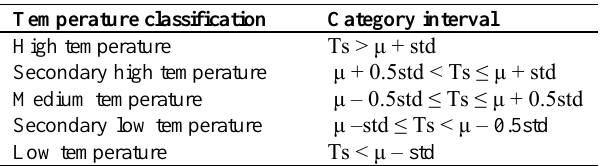
Table 1 LST classification scheme based on mean-standard deviation method (in this table Ts, μ and std respectively indicate normalized LST value, mean and standard deviation) Temperature